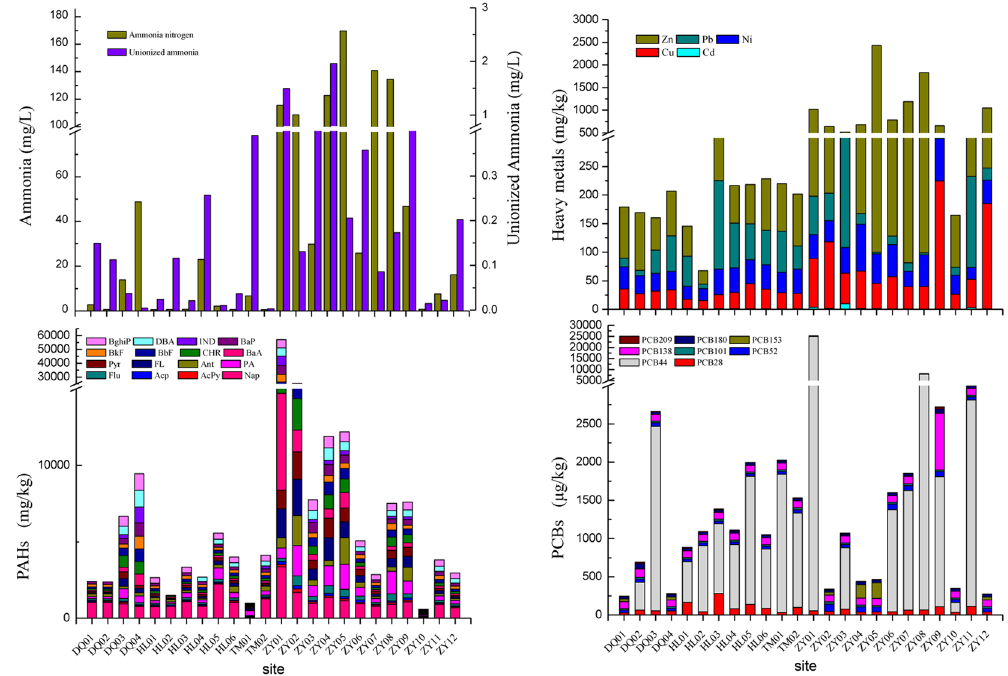
Figure 3. The contents of ammonia, heavy metals, PAHs, and PCBs in sediments.